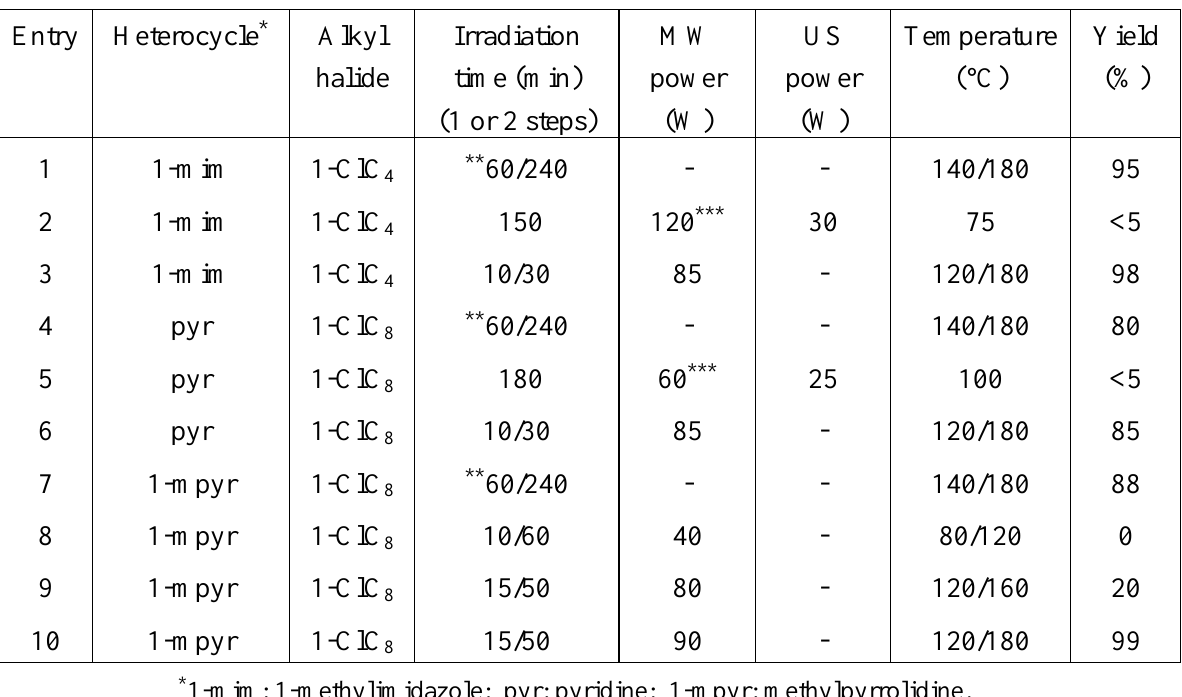
Table 2. N -alkylation of heterocycles under conventional heating, simultaneous MW/US irradiation or MW in a closed